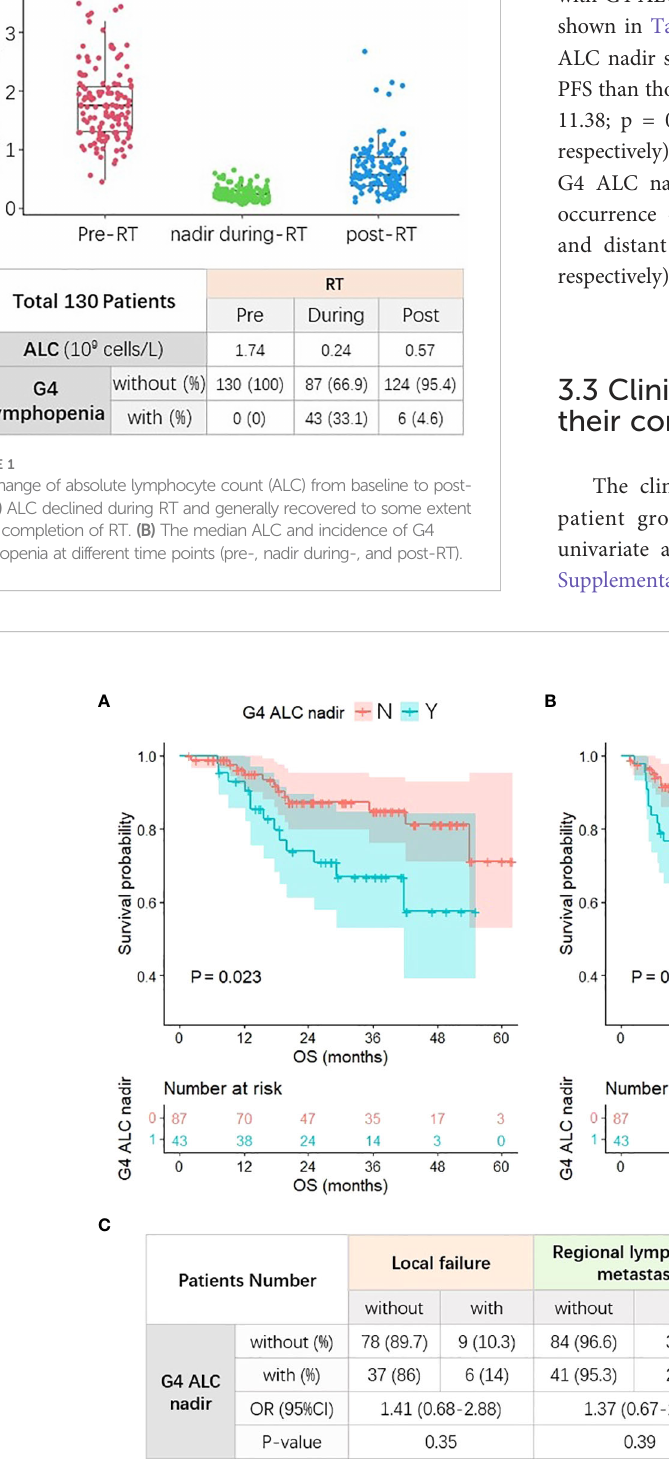
FIGURE 2 G4 ALC nadir and different treatment outcomes. (A) Patients with G4 ALC nadir had worse overall survival (OS) (p = 0.023). (B) Patients with G4 ALC nadir had worse progression-free survival (PFS) (p = 0.054). (C) The incidence and risk of local failure, regional lymph node metastasis, and distant metastasis after RT in patients with G4 ALC